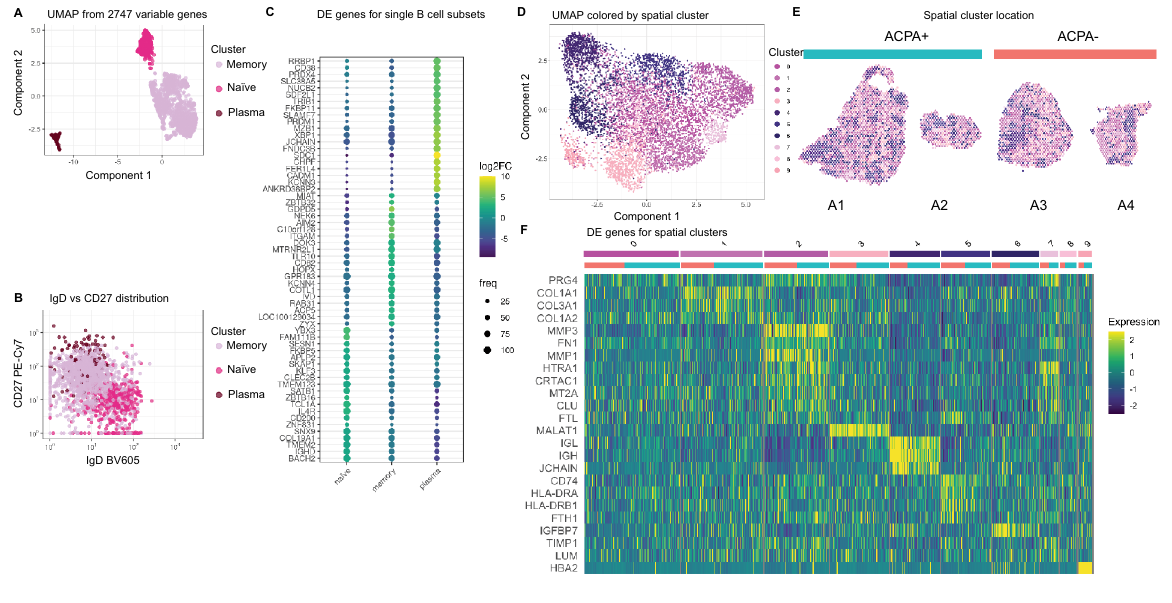
Figure 2. Identification of synovial B cell clusters and assessment of context relevant markers. ( A ) The UMAP dimensionality reduced B cell transcriptome from A2–A4 reveals the presence of a naïve, a memory and a plasma cell cluster. ( B ) The scRNAseq annotation translates back onto the expected phenotypic protein expression by flow cytometry. ( C ) Average log2FC and robustness of expression for differentially expressed (DE) genes of B cell transcriptomes show marker genes for naïve, memory and plasma cells. ( D ) UMAP on spatial transcriptomics data colored with the ten nearest neighbor clusters. ( E ) Clusters are shown on the tissue sections. ACPA+ samples are indicated by turquoise color, and ACPA− in orange. ( F ) Differentially expressed genes between the ten clusters (indicated by same colors as in ( D ). Cluster 4 shows genes strongly associated to plasma